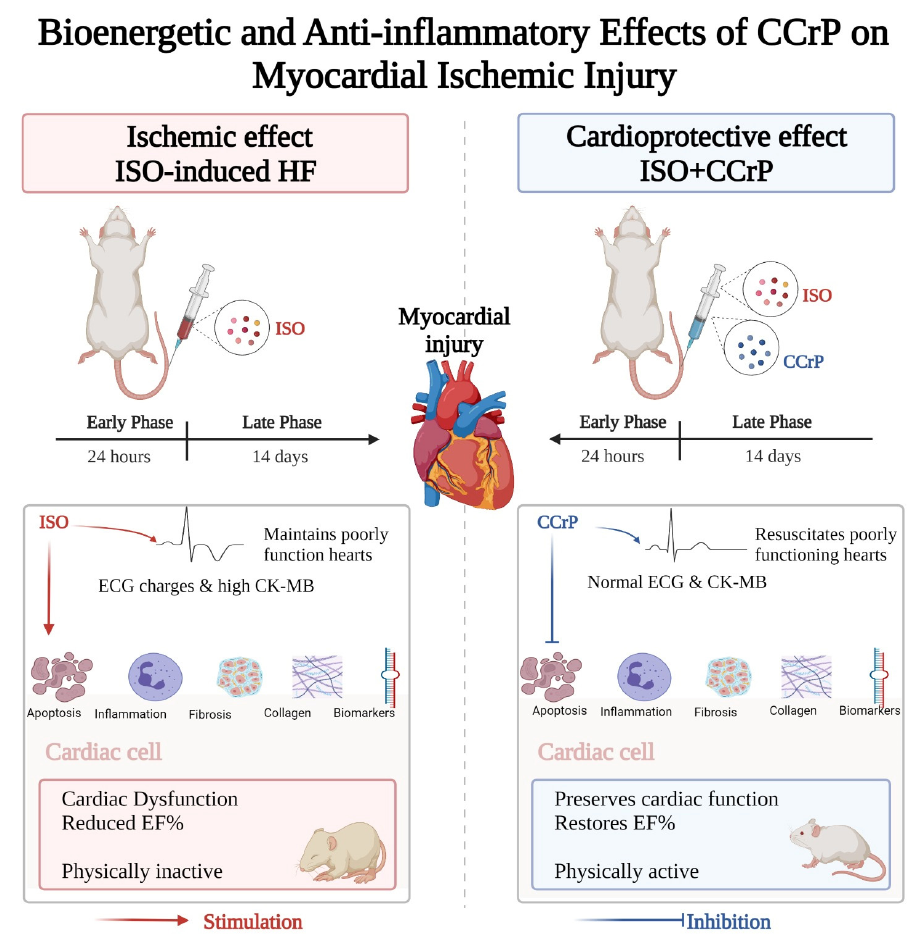
Figure 1. A flow diagram illustrating that the administration of CCrP prevented ischemic injury and resuscitated poorly functioning hearts at the early acute phase of 24 h after the second ISO injection, as shown by normal ECG/ST and CK-MB levels. After 14 days, CCrP prevented the development of HF as indicated by a reduction in apoptosis, inflammation, biomarkers, cardiac remodeling (fibrosis/collagen deposition), and heart weight, with the restoration of the normal ejection fraction, cardiac function, and physical activity in the ISO/CCrP rats. ISO: isoproterenol; CCrP: cyclocreatine phosphate.